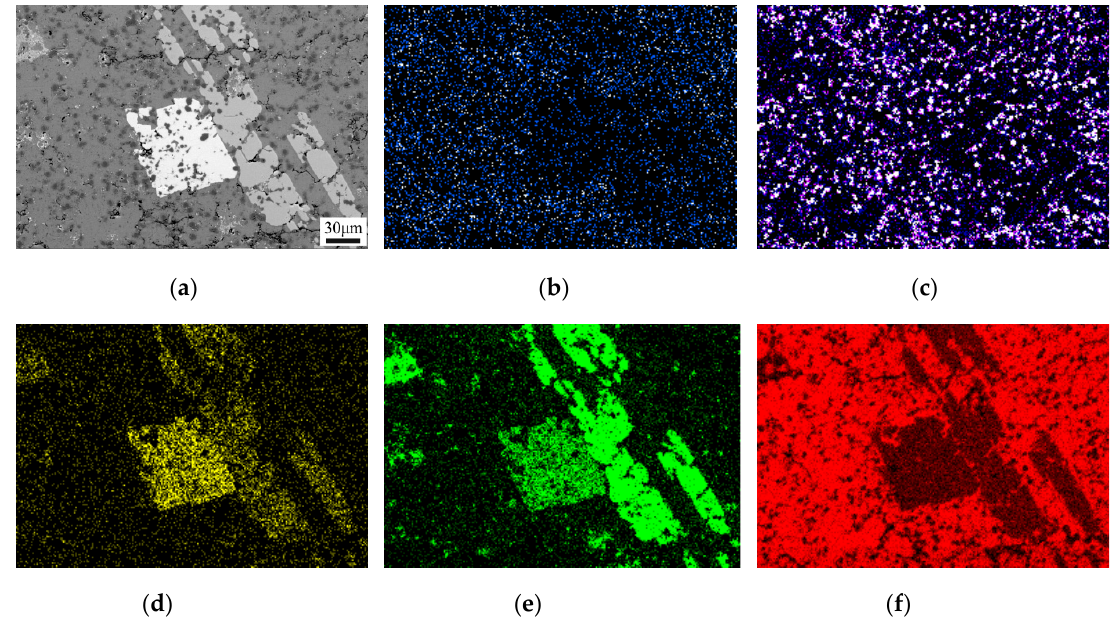
Figure 6. Surface scanning of the Al-TiO 2 -C-0.2La 2 O 3 refiners. ( a ) SEM, ( b ) O element, ( c ) C element, ( d ) La element, ( e ) Ti element, and ( f ) Al element.